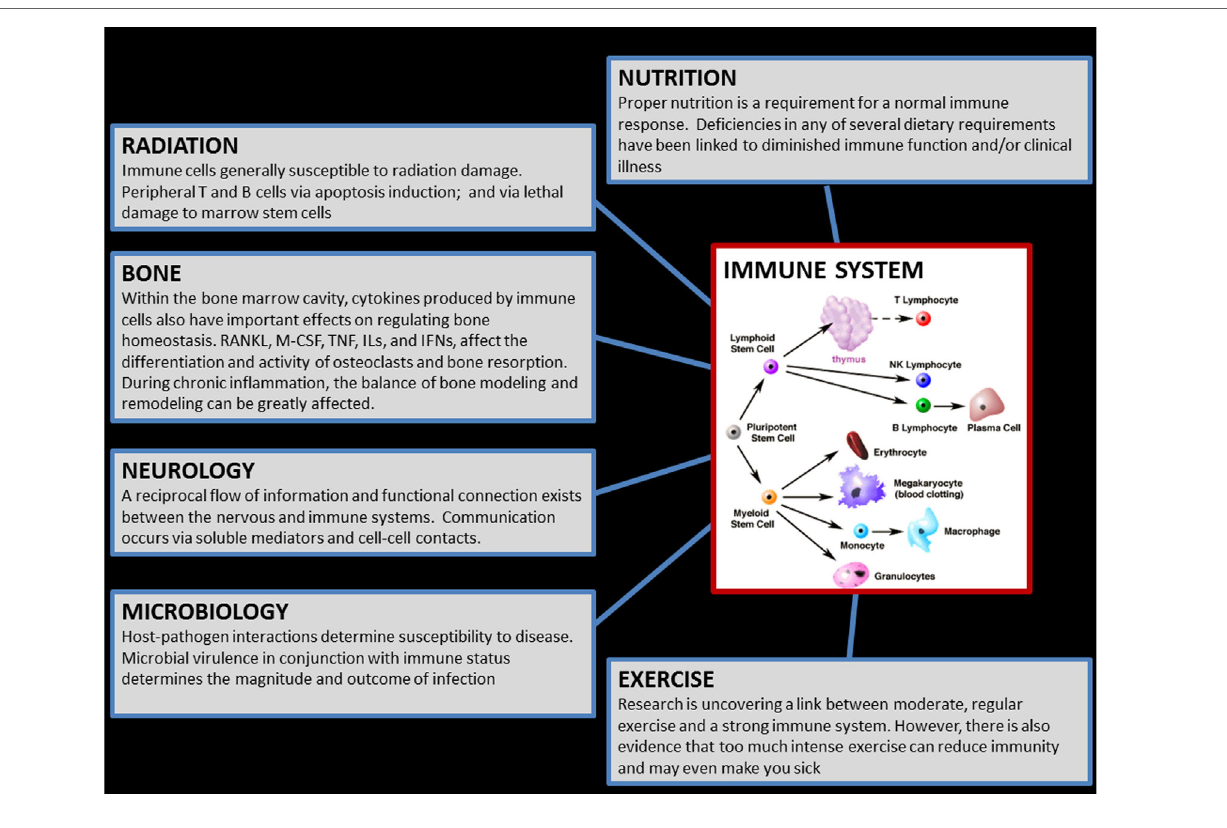
FiguRe 1 | Graphic which illustrates the translational aspects of the immune system. The cells of the immune system, located in virtually everywhere throughout the body, exchange reciprocal information with, and influence/are influenced by, most of the other physiological systems in the human body. Therefore, countermeasures for immune may influence other body systems, and conversely any biomedical countermeasures implemented (e.g., for bone) during flight may similarly have bystander effects on immunity. (Cellular graphic sourced from “The Biology Project,” University of